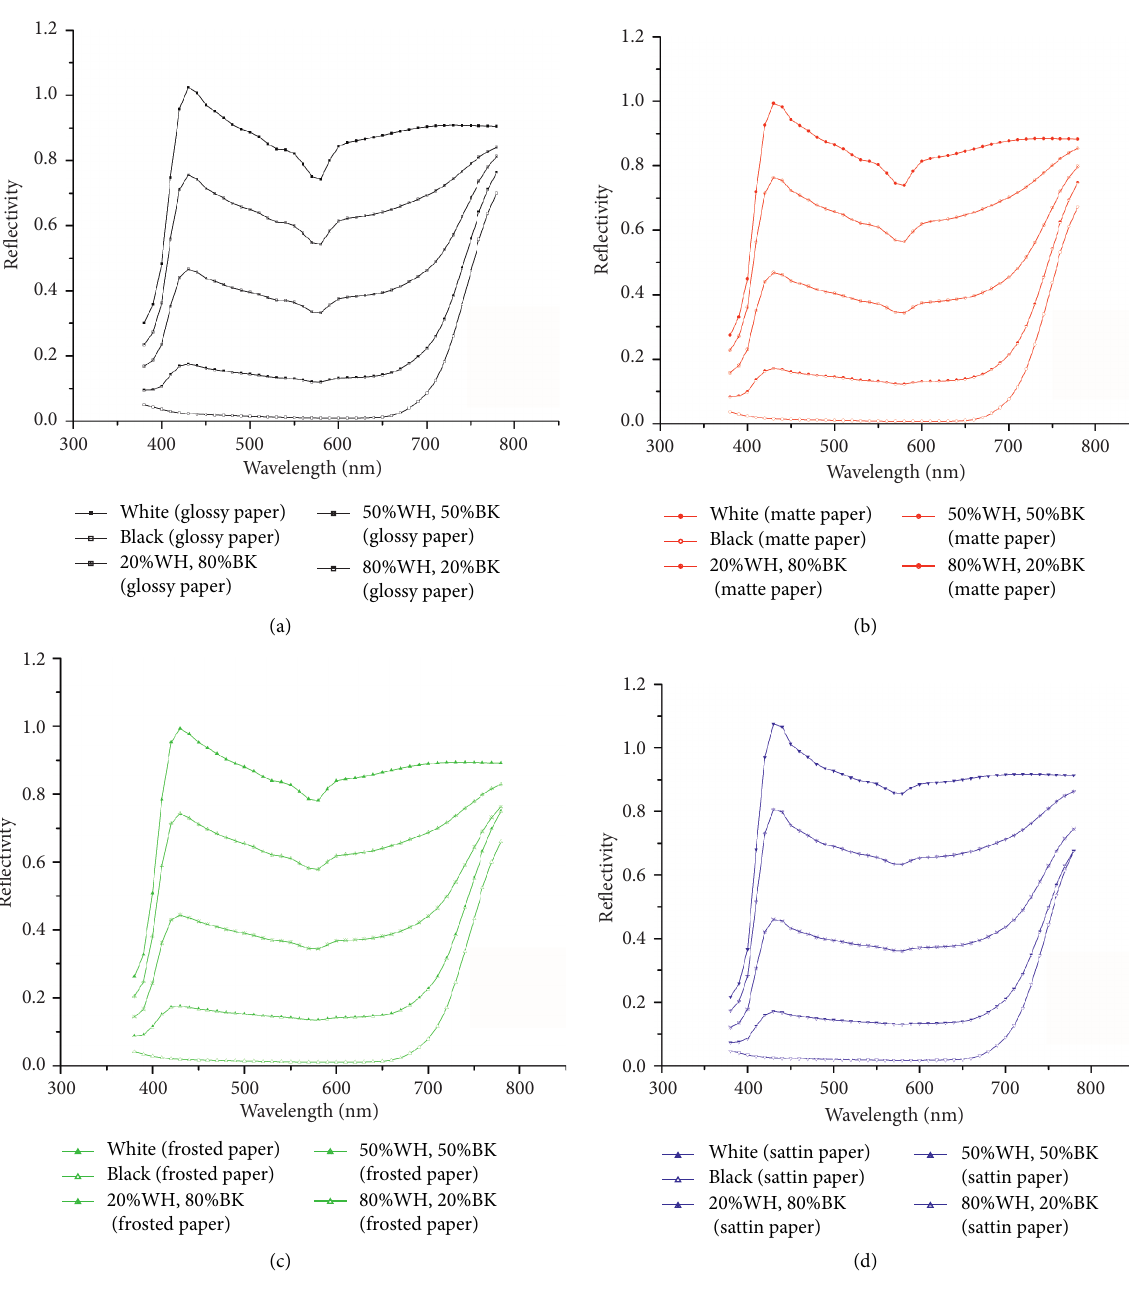
Figure 4: Reflectance spectra of mixed pixels on different